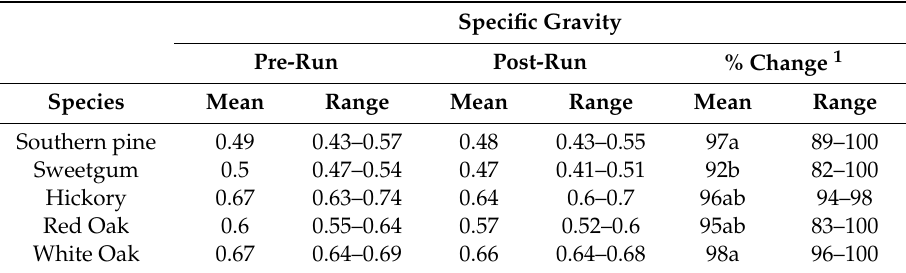
Table 3. Beginning and end specific gravity for the five species for the wet-deck run.